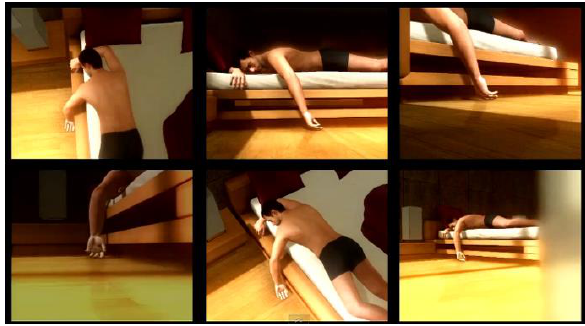
Figure 6 | We can see different types of shots being used within an effect of split screen. Picture from “ Heavy Rain” .